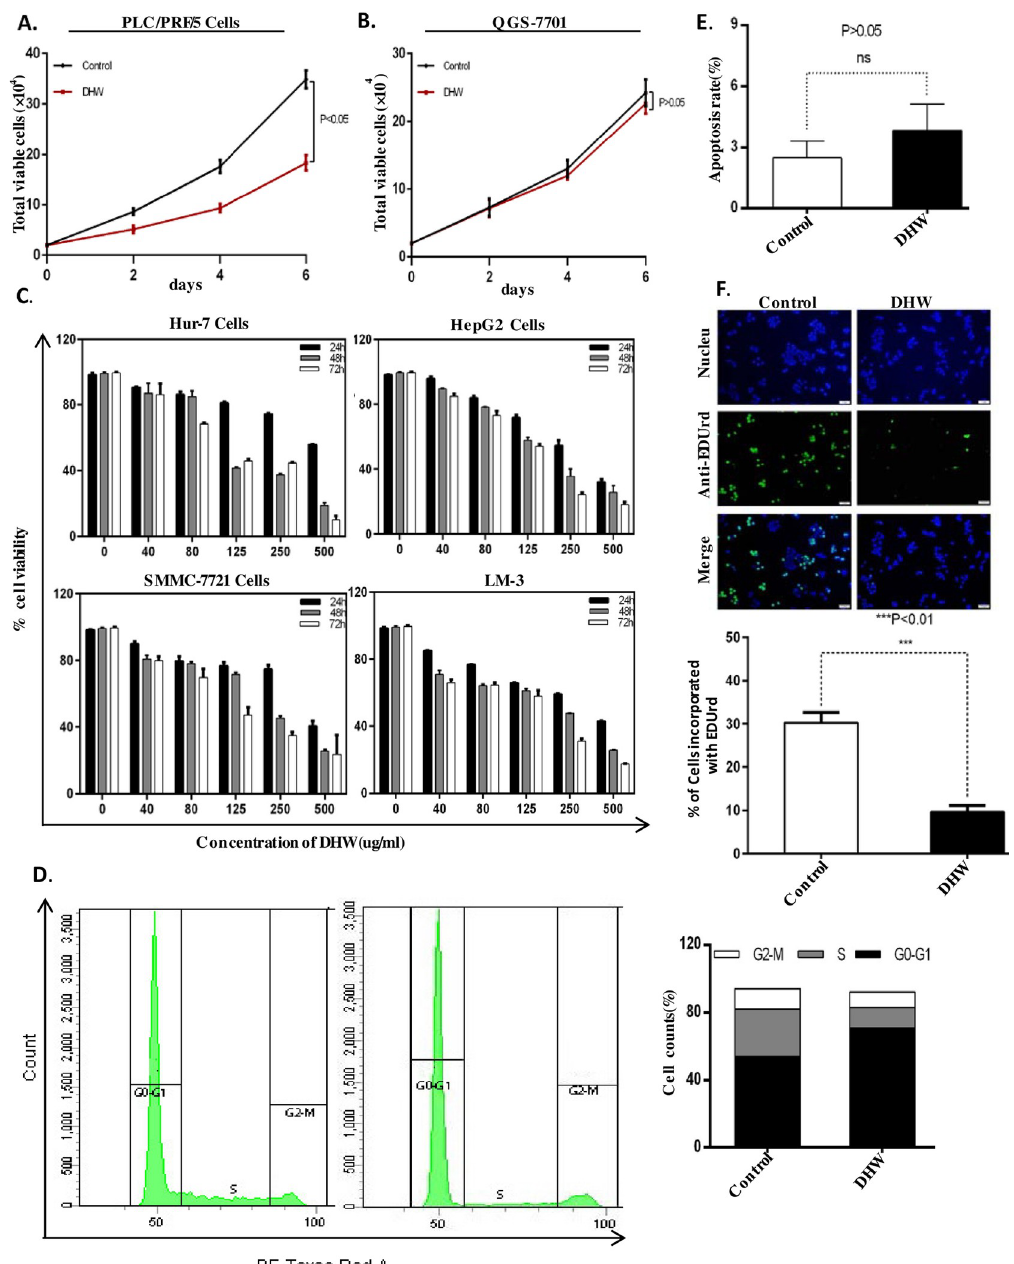
Fig 1. PLC/PRF/5 (A), and QSG-7701 (B), cells (2 × 10 4 ) were seeded in 12-well plates and cultured in DMEM treated with DHW (40 μ g/ml). The number of cells was counted at the indicated times. C, Cell viability determined by MTT assay. Liver cancer cells were treated with different concentrations of DHW extract for 24, 48, and 72 hrs, and cell viability was determined by MTT. D, DHW extract induces G0/G1 arrest of PLC/PRF/5 cell line. Cells were treated without or with 40 μ g/ml DHW extract for 48 hrs and then the cell cycle population was measured by flow cytometry. E, Apoptosis in PLC/PRF/5 cells determined by flow cytometry. Cells were treated without or with 40 μ g/ml DHW extract for 48 hrs, and then apoptosis was measured by flow cytometric analysis of cells stained with Houchest3324 and PI. The percentages of Houchest3324 or/and PI- positive cells are indicated. F, PLC/PRF/5 Cells were treated with DHW extract for 48 hrs before they were assayed for EdUrd incorporation. Data are presented as the mean ± SD of values from triplicate